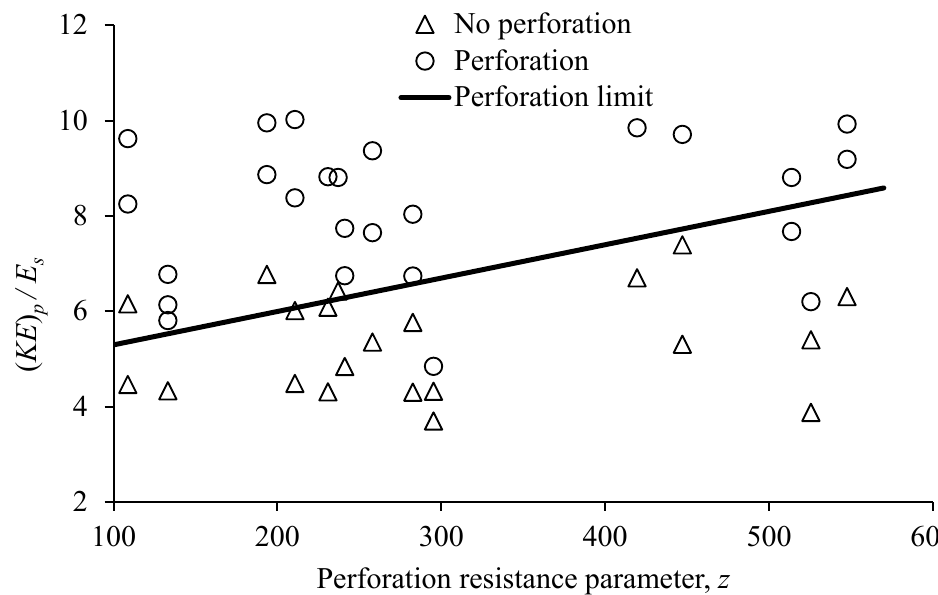
Figure 11. Variation of ( KE ) p / E s with perforation resistance parameter, z . (( KE ) p = projectile kinetic energy at strike, E s = energy absorbed in quasi-static punching).